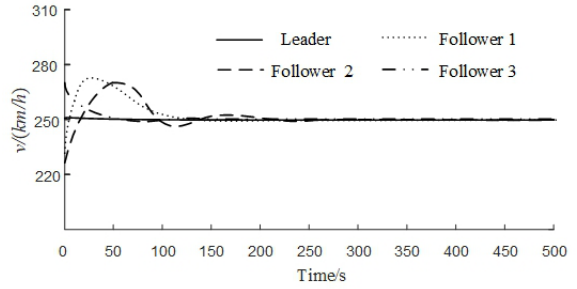
Fig. 2. The speed of trains in normal condition